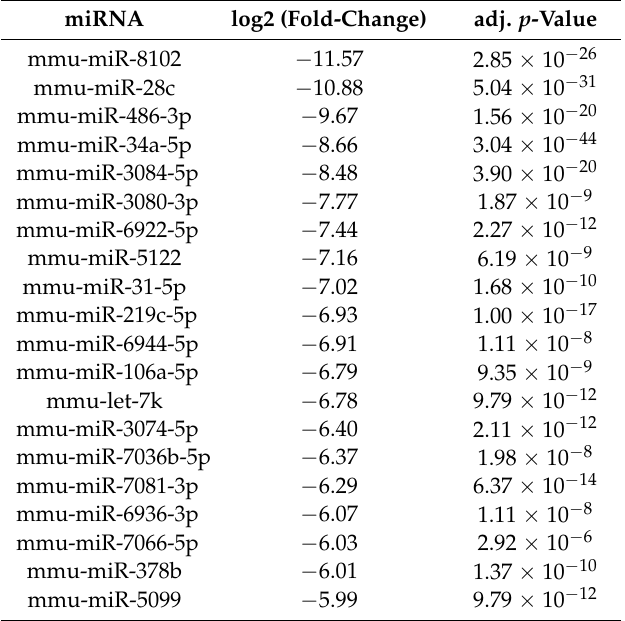
Table 2. Top 20 down-regulated miRNAs in SHH MB CSCs vs. NSCs. The entire dataset is reported in Table S2; adj.,